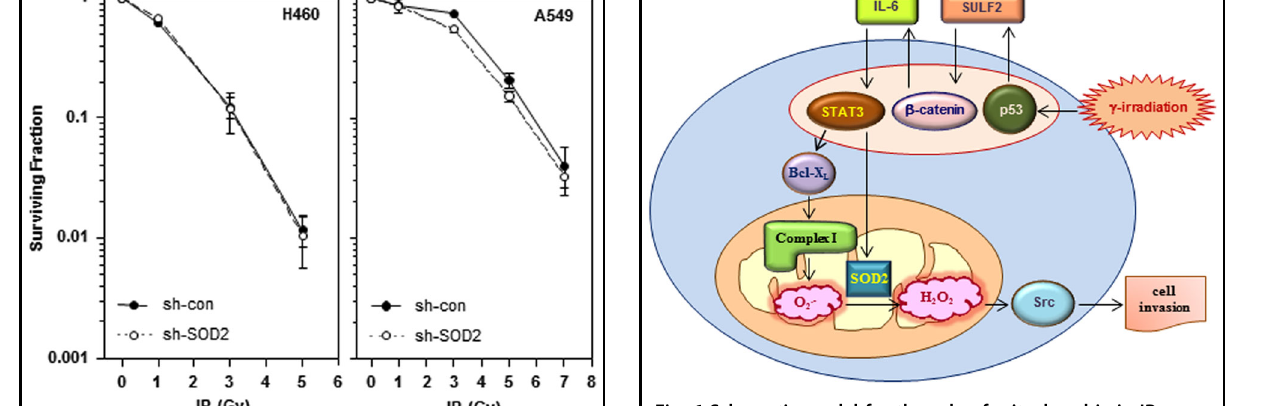
Fig. 6 Schematic model for the role of mitochondria in IR- induced cell invasion. STAT3 stimulated by IR via the p53/SULF2/ β - catenin/IL-6 pathway induces Bcl-X L and SOD2 expression. Bcl-X L increases the ability of complex I to produce O 2 (cid:129) − , and SOD2 converts mitochondrial O 2 (cid:129) − to H 2 O 2 , which, in turn, acts as a signaling molecule to promote cell